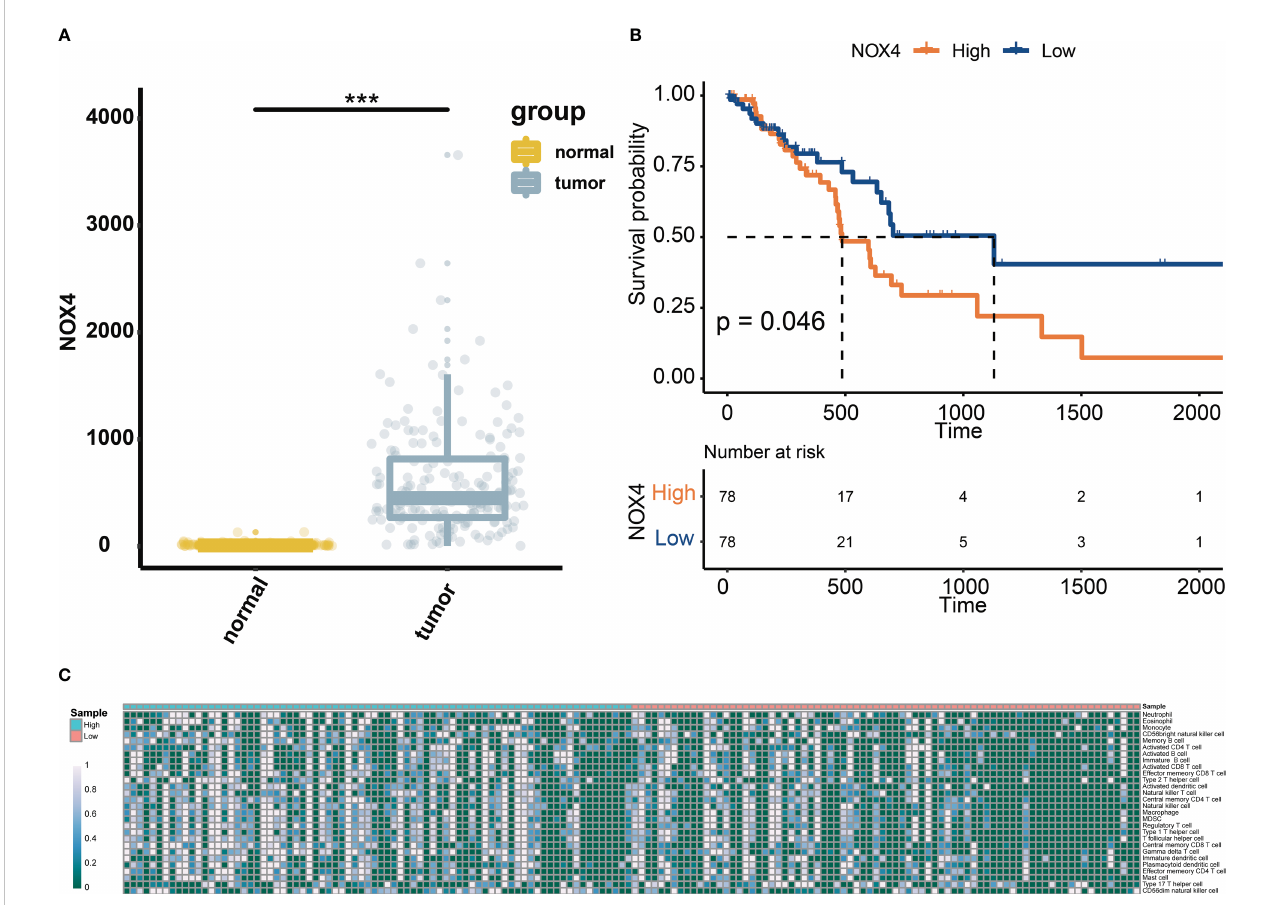
FIGURE 1 Expression of NOX4 in pancreatic tissue. (A) The levels of NOX4 expression in pancreatic tumors and normal tissues from TCGA and GTEx databases. (B) Kaplan – Meier curve for patients with high or low expression of NOX4. (C) Abundance of immune cells in pancreatic cancer patients with high and low expression of NOX4. ***p <